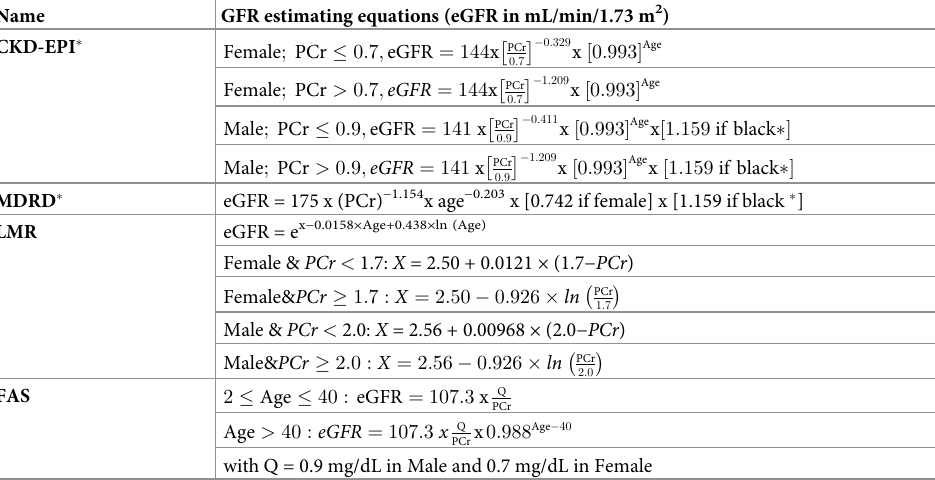
Table 1. Equations used to estimate glomerular filtration rate (mL/min/1.73m 2